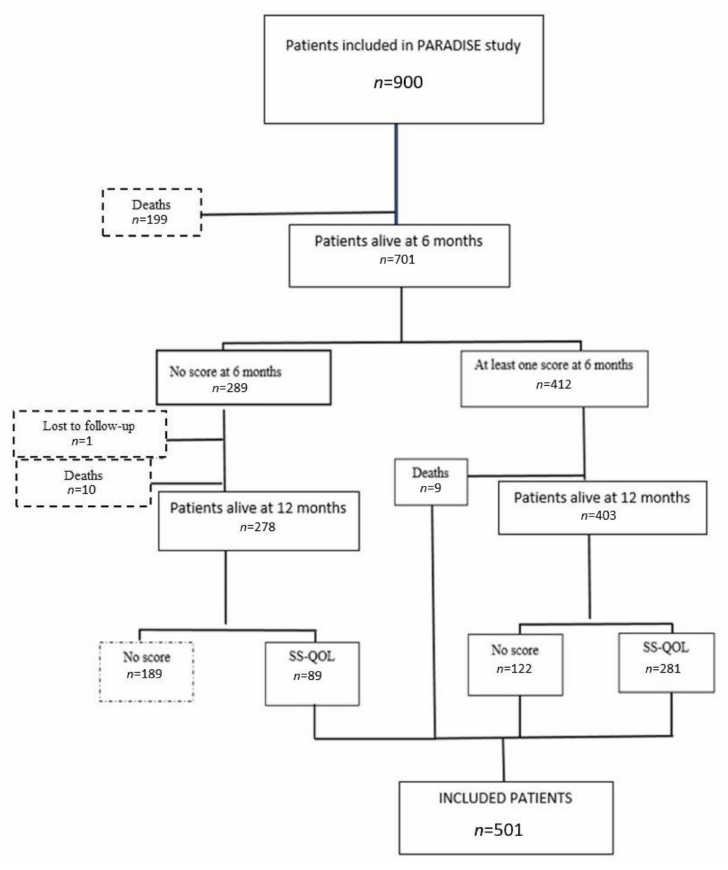
Figure 1. Participant selection